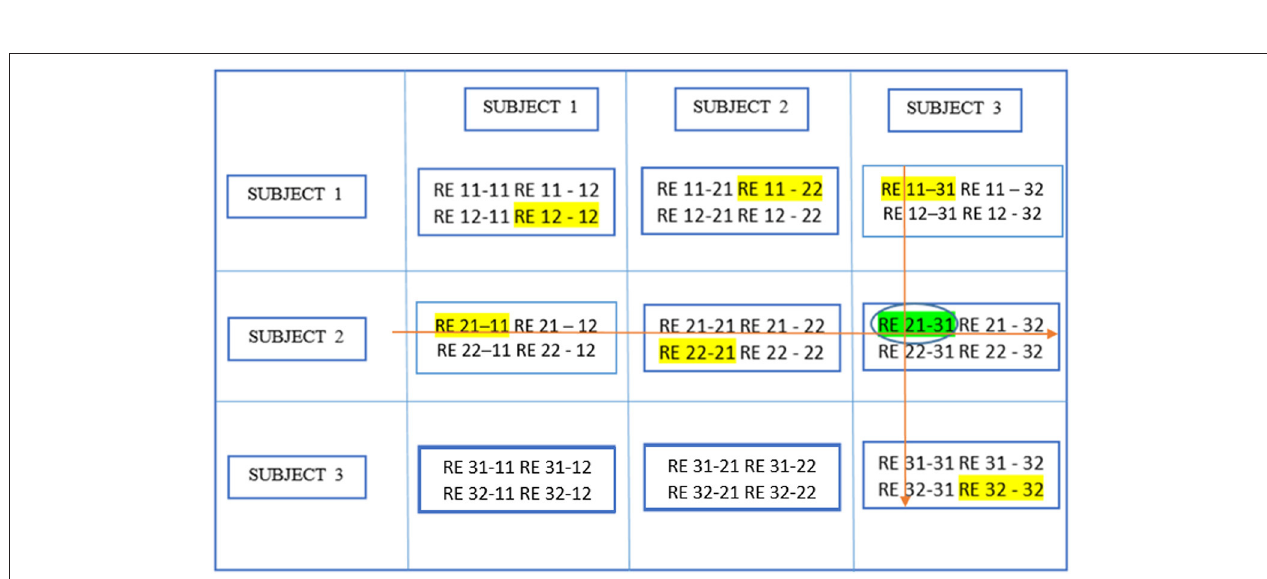
FIGURE 5 | Determine global maximum. In this figure, the global maximum has a circle around it with highlighting.